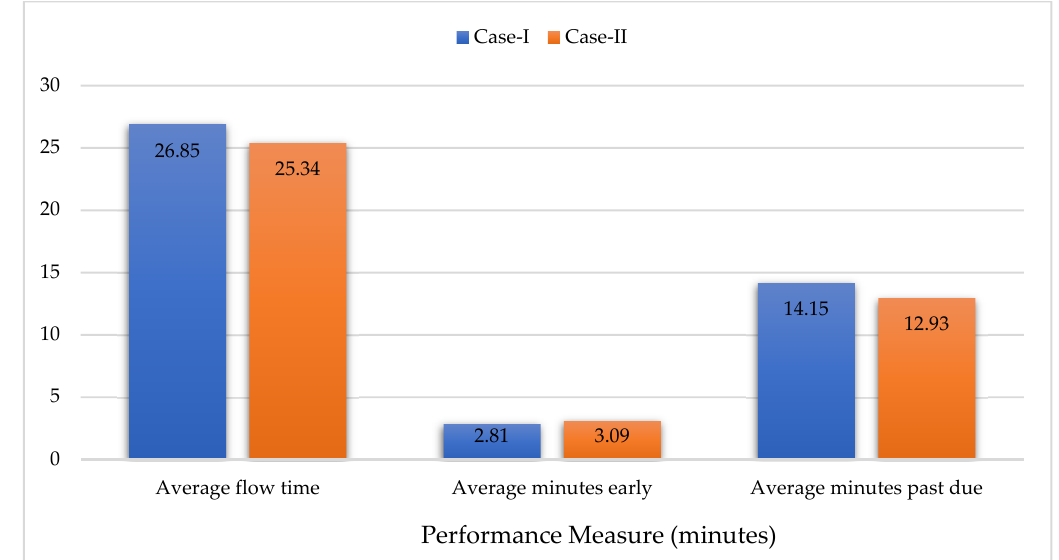
Figure 8. Comparison of the performance measures for Case-I and Case-II using the SPT rule.